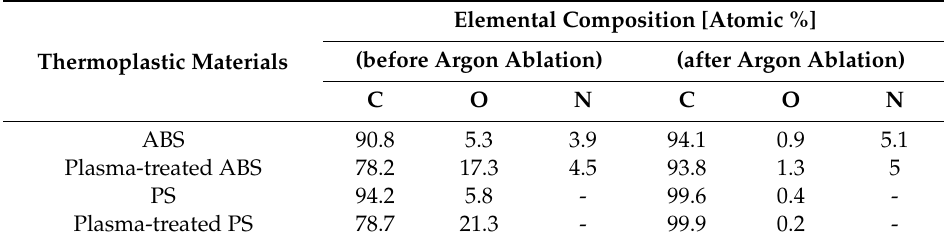
Table 5. Elemental composition of untreated and plasma-treated PS and ABS samples before and after surface ablation with low energy Ar